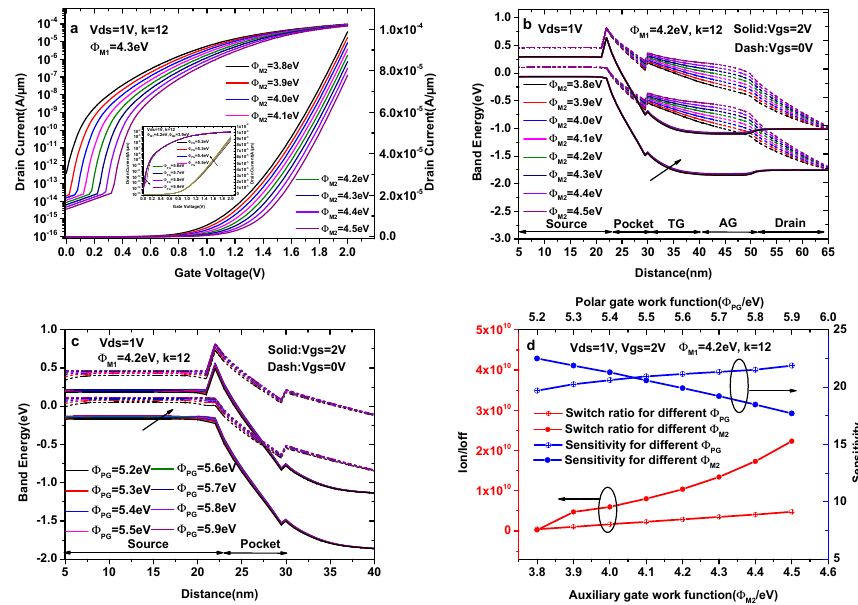
Figure 6. ( a ) Transfer characteristics of DMG-HJLTFET with different auxiliary gate work functions ( Φ M2 ); ( b ) energy band diagram of DMG-HJLTFET with different auxiliary gate work functions ( Φ M2 ); ( c ) energy band diagram of DMG-HJLTFET with different polar gate work functions ( Φ PG ); ( d ) the variation of sensitivity and switch ratios with different Φ M2 and Φ PG . The inset indicates the transfer characteristics of a DMG-HJLTFET with different